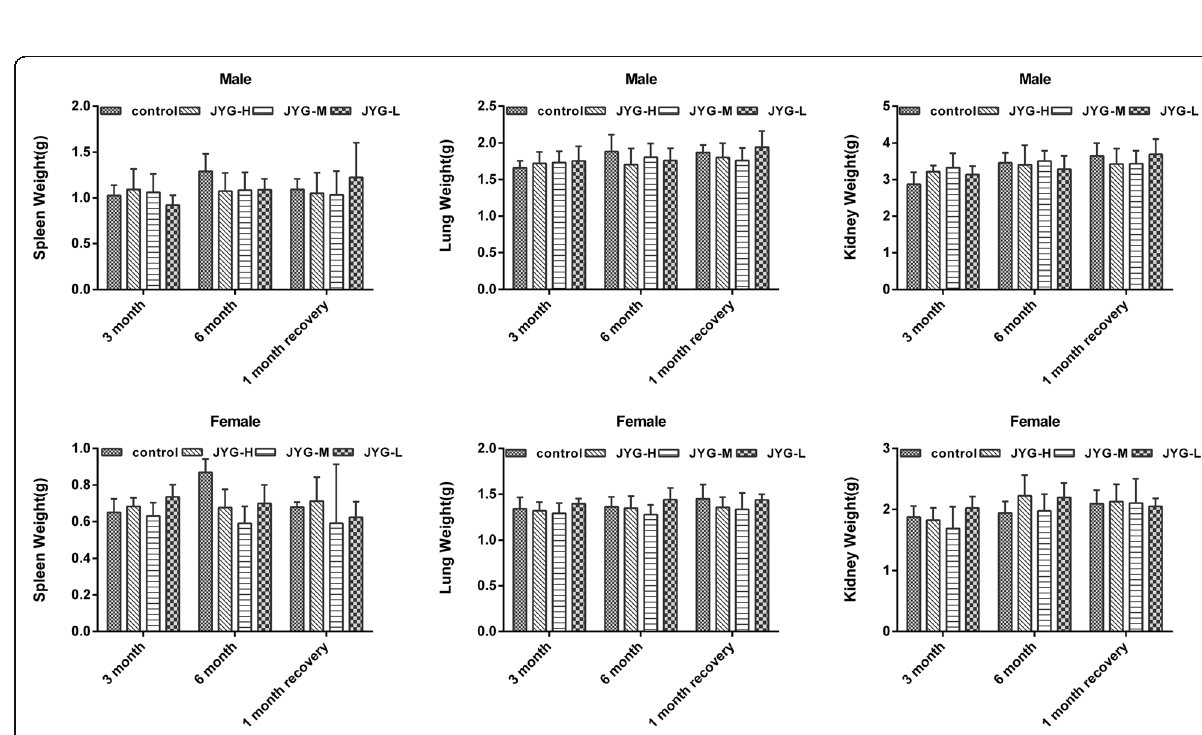
Fig. 3 Organs weight of brain, heart and liver in the control and JYG-treated groups in the chronic toxicity test. Note: JYG-H, JYG-M,JYG-L: Jueyin granules high-dose, medium dose, low-dose group, respectively. The values are expressed as mean ± SEM ( n = 10 rats for 3 months; n = 17 – 19 rats for 6 months; n = 10 rats for 1 month recovery). * P < 0.05 statistically significant compared to control group